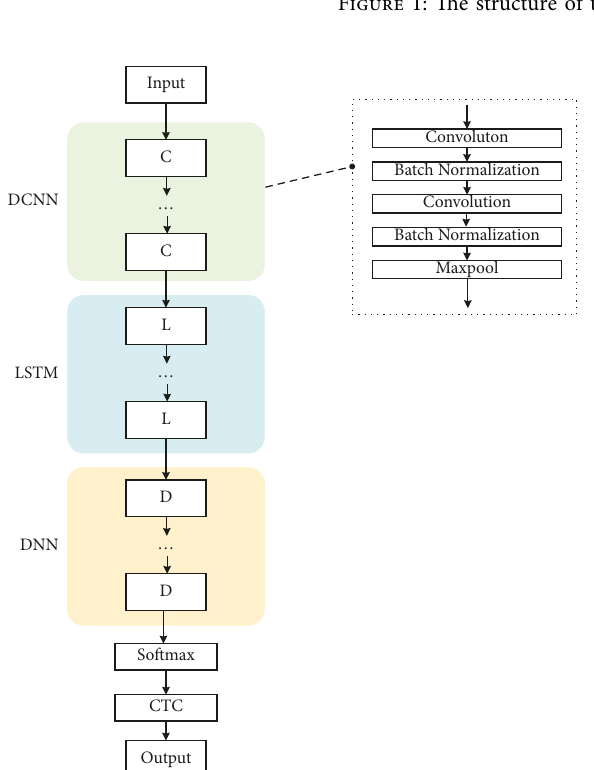
Figure 2: The structure of the DLD acoustic